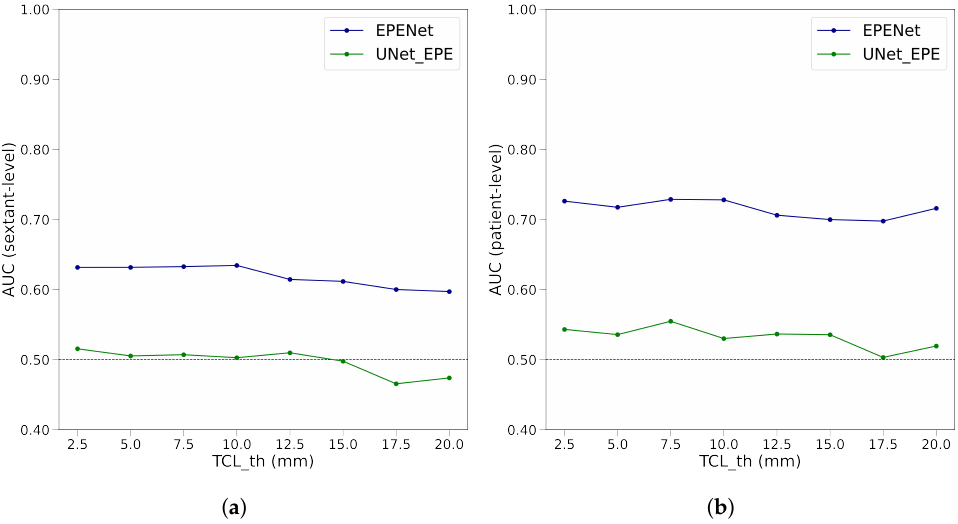
Figure 3. Grid search over the tumor-capsule contact line length threshold parameter ( TCL th ) for EPENet and UNet_EPE. The two panels correspond to the evaluation metric used (displayed on the y axis): sextant-level AUC in panel ( a ) and patient-level AUC in panel ( b ). The x axis shows the values of TCL th in millimeters. Results are averages computed over the validation sets of the five cross-validation data